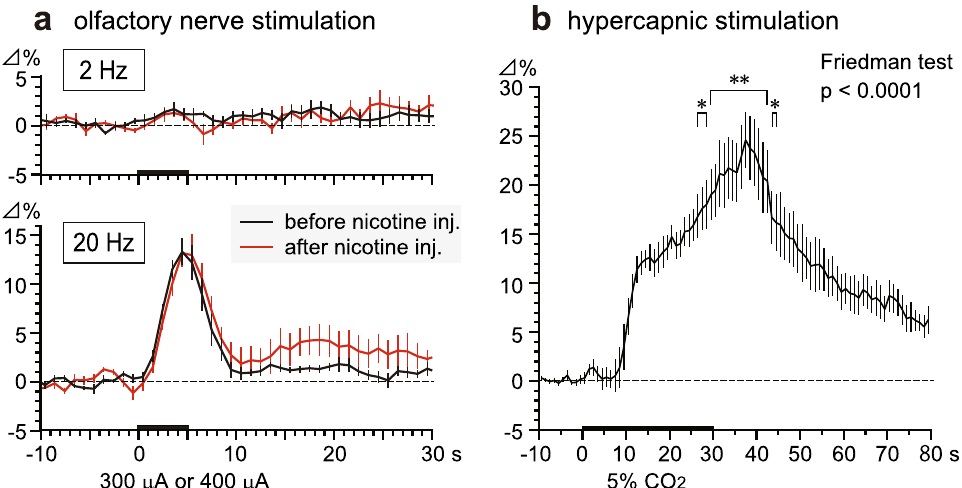
Fig. 3 Changes in the olfactory bulb blood flow following nicotine administration or hypercapnia in aged rats. a Graph of the time course of regional blood flow responses in the olfactory bulb ipsilateral to the olfactory nerve stimulation. The blood flow values were averaged every 1 s before (black line) and after (red line) nicotine injection (30 μg/kg). The stimulus frequencies used were 2 Hz (upper graphs) and 20 Hz (lower graphs). Changes in regional blood flow are expressed as percentages of the corresponding basal values (the mean value from those recorded over the 10 s before time zero). Each point and vertical bar represent a mean SEM ( n 5). b Graph of olfactory bulb regional blood flow response time ± = courses, averaged every 1 s ( n